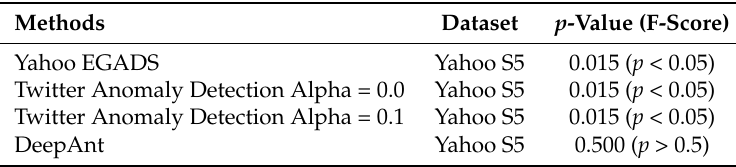
Table 6. The p -values of our method compared to the other methods on the whole Yahoo Webscope S5. Methods